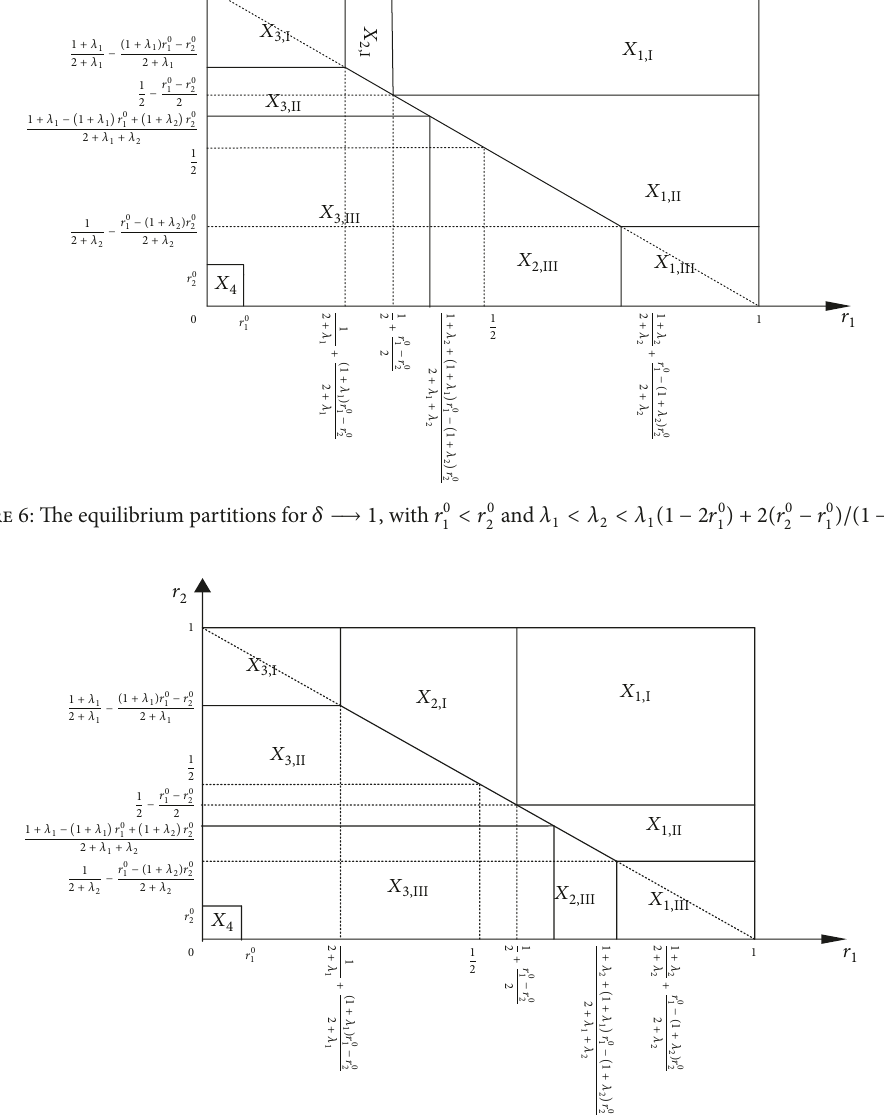
Figure 7: The equilibrium partitions for 𝛿 󳨀→ 1 , with 𝑟 0 1 < 𝑟 0 2 and 𝜆 1 (1 − 2𝑟 0 1 ) + 2(𝑟 0 2 − 𝑟 0 1 )/(1 − 2𝑟 0 2 ) < 𝜆 2